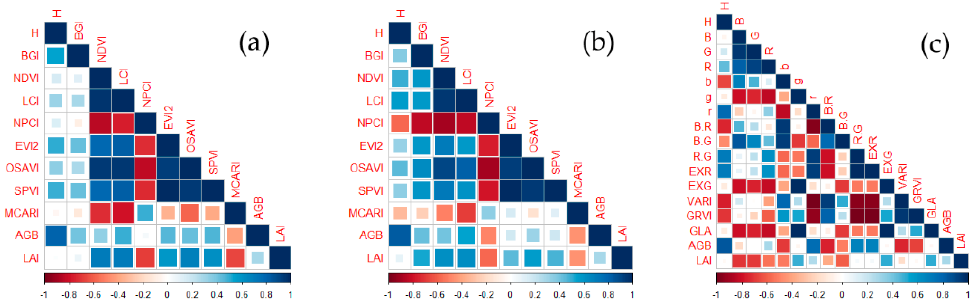
Figure 5. Pearson correlation coefficient between VIs, crop height (H), AGB and LAI: ( a ) G-Vis; ( b ) UHD-Vis; ( c ) DC-VIs.